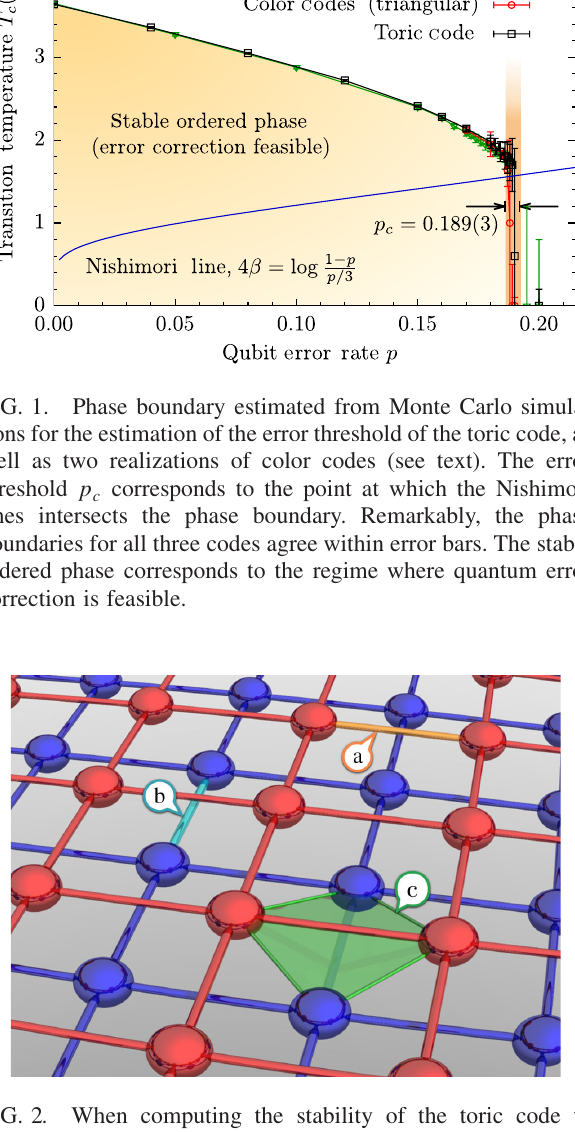
FIG. 2. When computing the stability of the toric code to depolarization, the problem maps onto a classical statistical Ising model on two stacked square lattices. In addition to the standard two-body interactions for both top (a) and bottom (b) layers, the resulting Hamiltonian also includes four-body terms (c) that introduce correlations between the